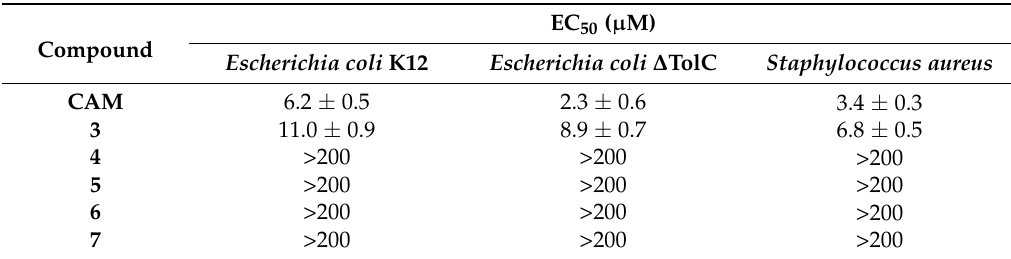
Table 2. In vivo antibacterial activity of CAM and PA–CAM conjugates against wild-type (WT) and mutant strains of bacteria, expressed by the half-maximal effective concentration (EC 50 ) value. Data represent the mean ± SD values obtained from three independent experiments.